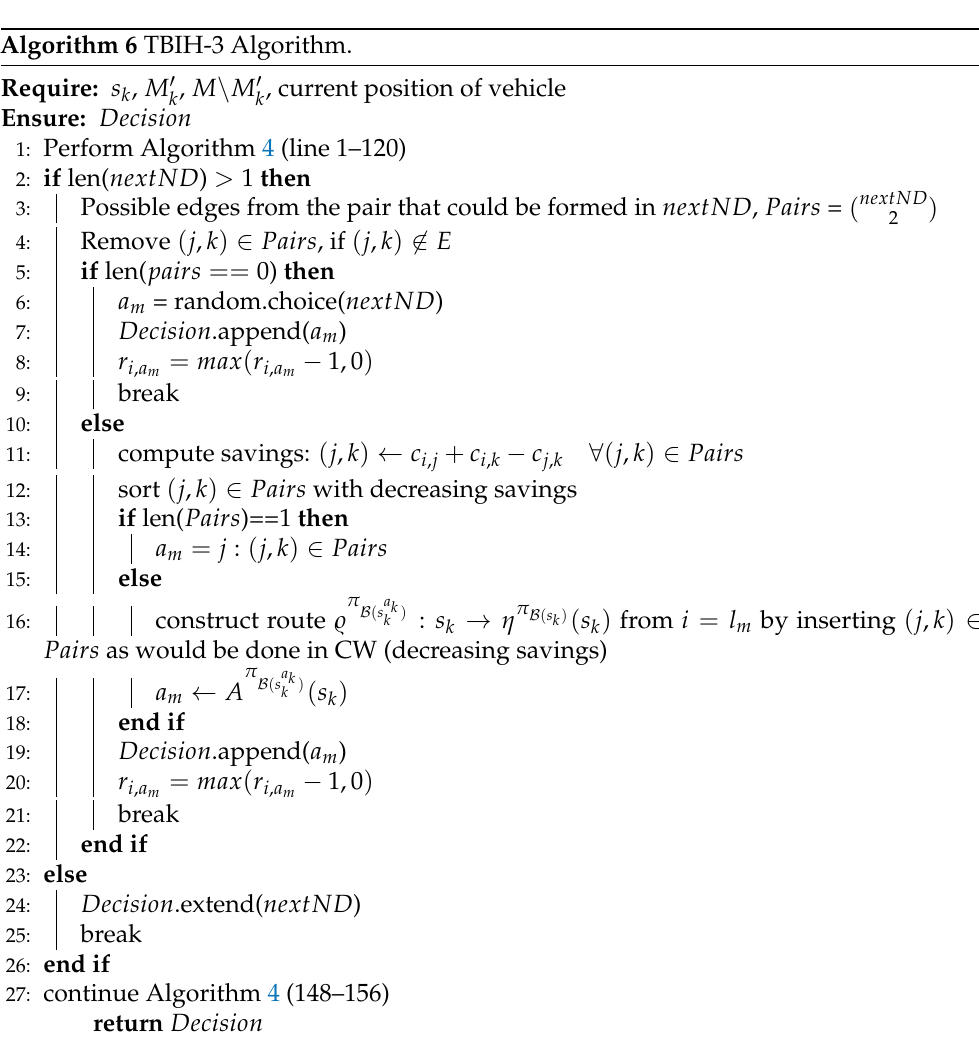
Figure 3. Performing DCW in TBIH-3 in an example network ( a ) with node 3 as current position of vehicle m and node S2 as an emergency shelter. The components for performing CW are selected in ( b